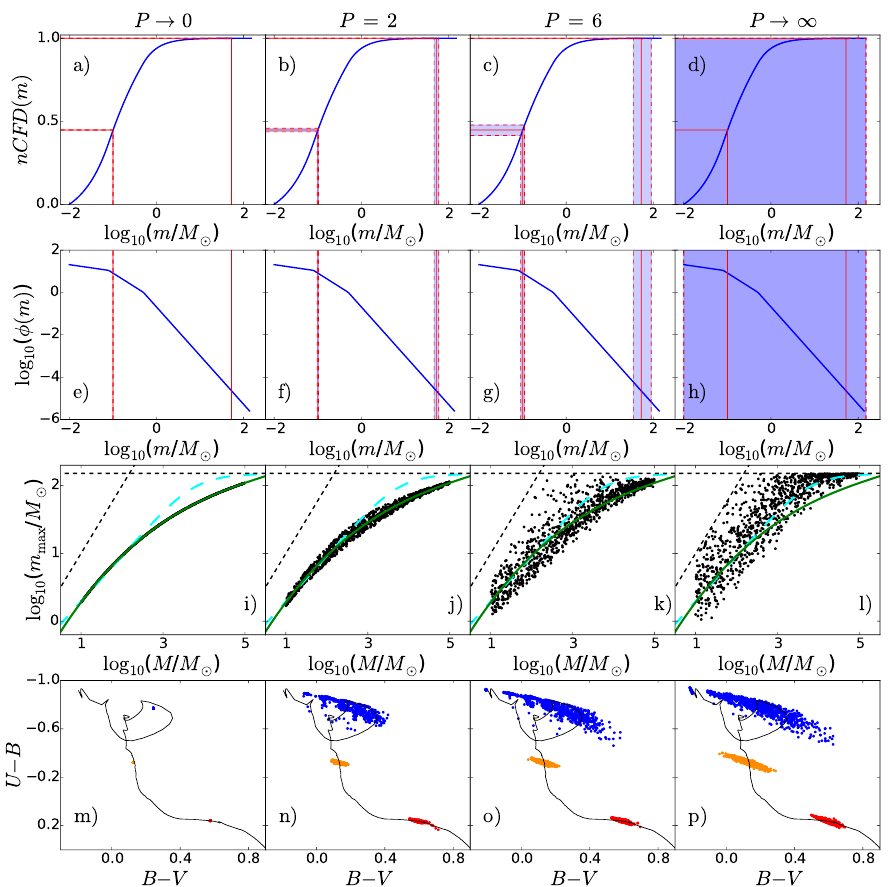
Fig.1. Scheme of the RRS method, allowing a continuous transition between OS and RS. The columns of the panels represent the results obtained with different values of the expansion factor P , indicated on the top. The upper two rows of the panels show the cumulative distribution function and the IMF, respectively. These panels demonstrate the transition between OS and RS, schemed for two stars, one in the low-mass regime and another in the high-mass regime of the IMF. For each star generated by OS, a bin is defined around its mass. For the purpose of illustration, the bin in the low-mass regime is enlarged by a factor of 200 on a linear scale. In these mass bins, the stellar masses are resampled. The third row of the panels shows the relation between the mass of the most massive stars, m max , and the mass of their host clusters, M , compared to the Weidner et al. (2013; green solid line) and Kroupa et al. (2013; cyan long-dashed line) relations. The oblique black dashed line is a one-to-one relation between m max and M , and the horizontal black dashed line is the physical upper stellar mass limit, 150 M (cid:12) . The bottom row of the panels demonstrates the impact of the increase of stochasticity in the cluster stellar mass sampling on the color distributions of these model clusters. The model clusters shown are for the mass log 10 ( M / M (cid:12) ) = 4 and ages of log 10 ( t / yr ) = 7 , 8 , 9 (blue, orange,